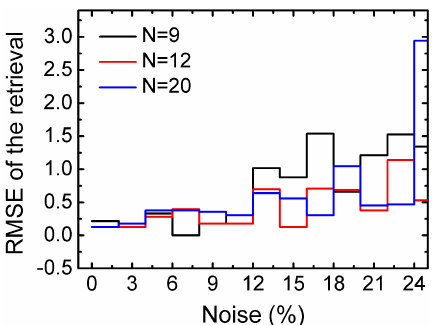
Figure 7. Dependence of RMSE for CDR estimation on noise level when 9, 12, and 20 observations are adopted in the retrieval. The percentage of noise represents the standard deviation of the Gaus- sian noise added on the simulated measurements. In all cases, the EV and COT were assumed to be 0.05 and 5, respectively.